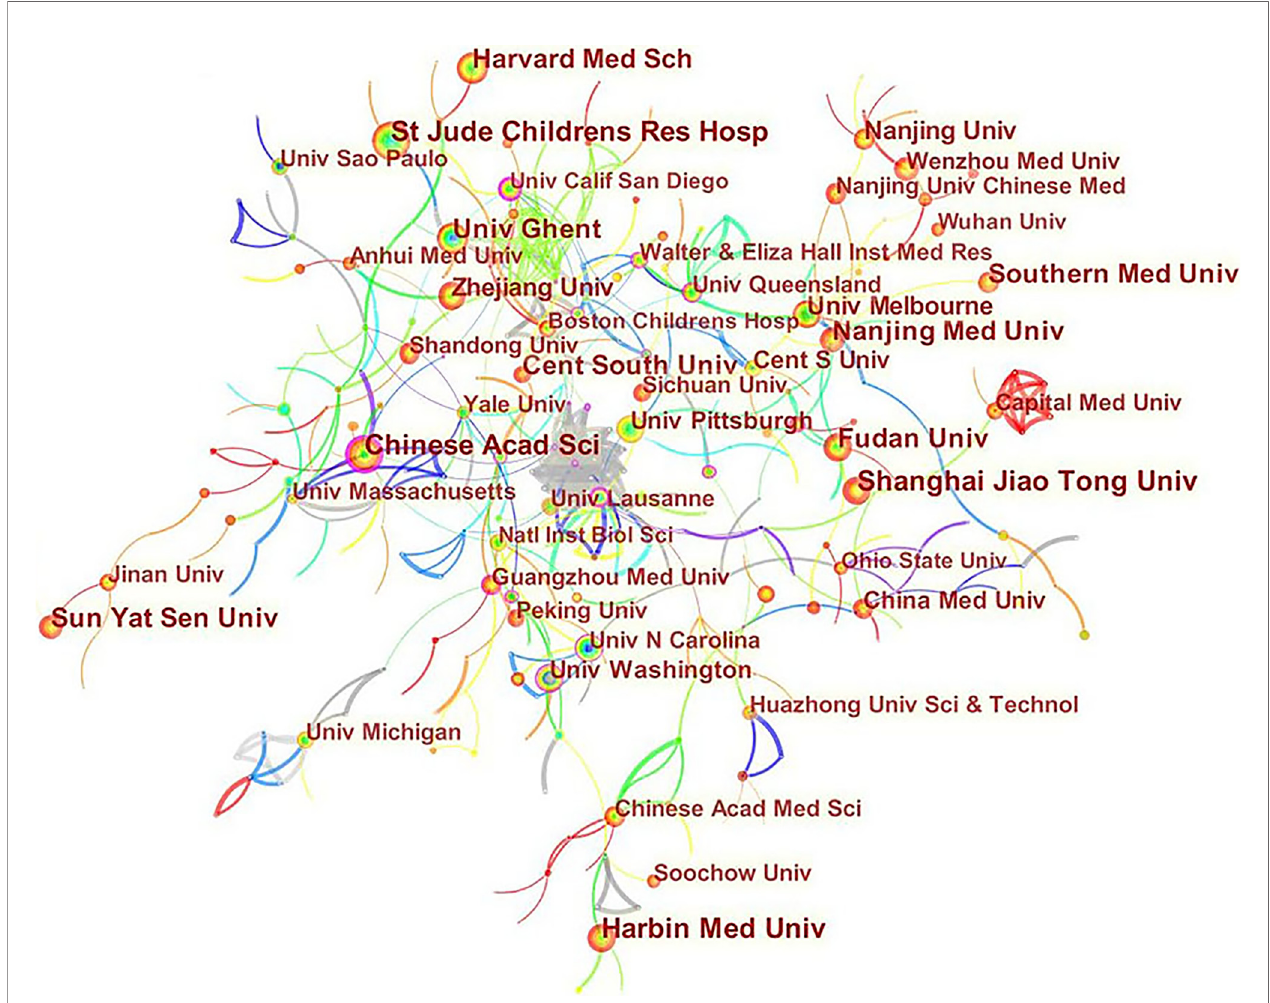
FIGURE 4 | Distribution of publications from different institutions.